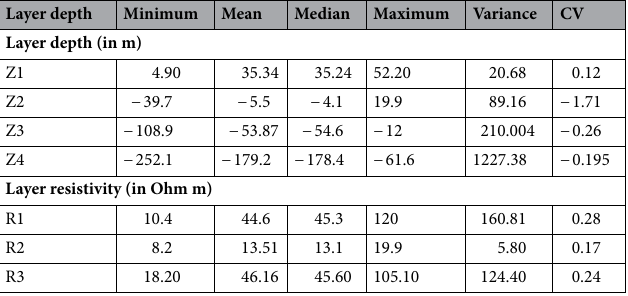
Layer depth RMSE R 2 ME